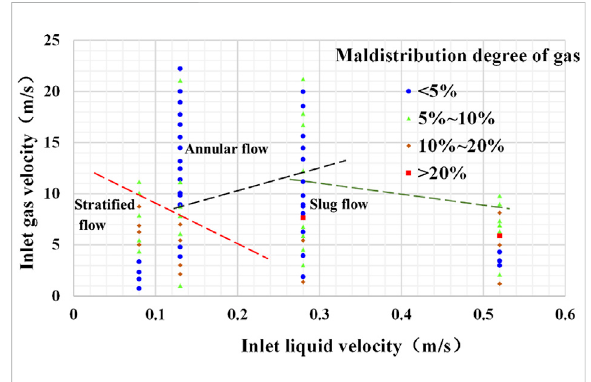
FIGURE 17 Scatter diagram of liquid maldistribution degree in different fl ow patterns in horizontal manifold with fl ute pipe.